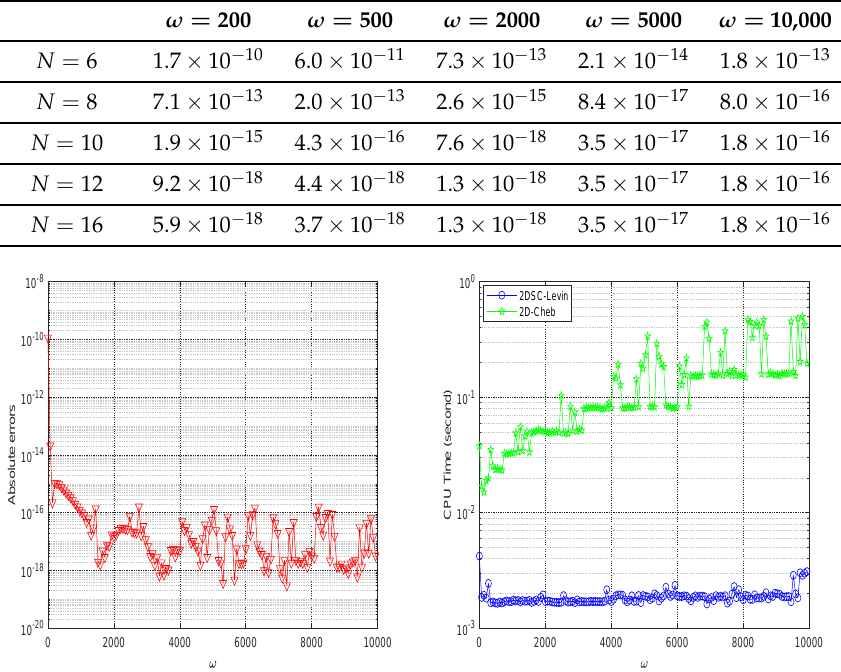
Figure 5. Comparison between 2DSC-Levin and 2D-Cheb in Example 1, ω is a variable (left: absolute errors, right: CPU time).